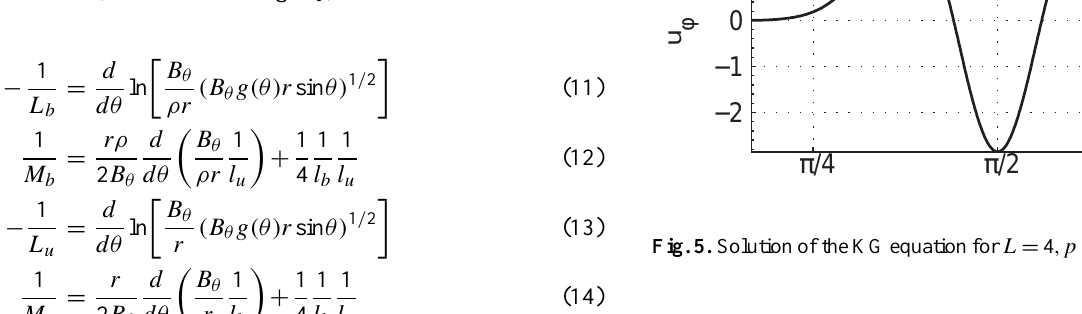
Fig. 5. Solution of the KG equation for L = 4 ,p = 3 : 2nd harmonic.